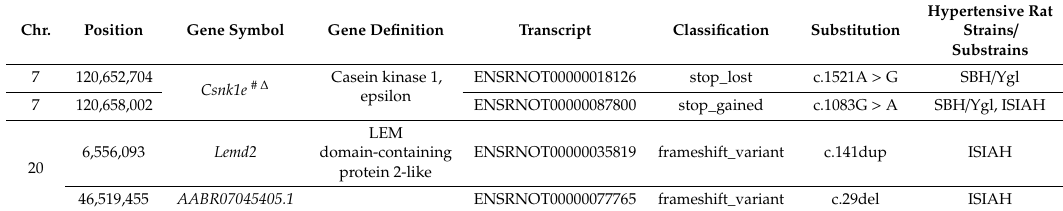
Table 3. SNPs causing functionally significant structural rearrangements of transcripts that may be related to the development of the hypertensive state in OXYS